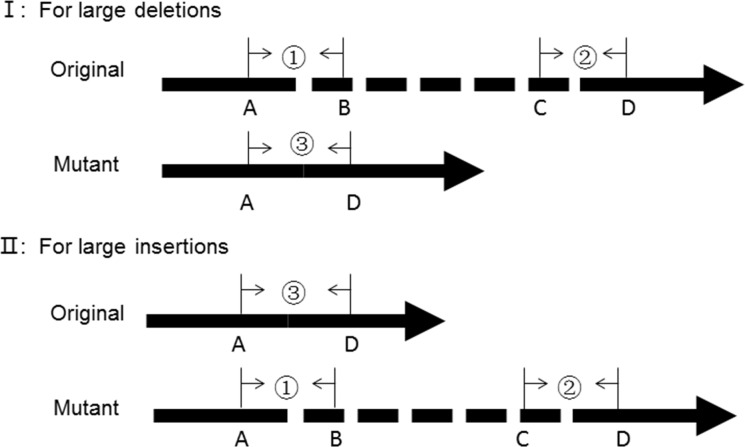
Schematic diagram of primer design for large indels.①, ②, ③ were three pair primers designed for each large indel, and yield three amplicons AP1, AP2, AP3 respectively. BC was the inserted or deleted sequence.